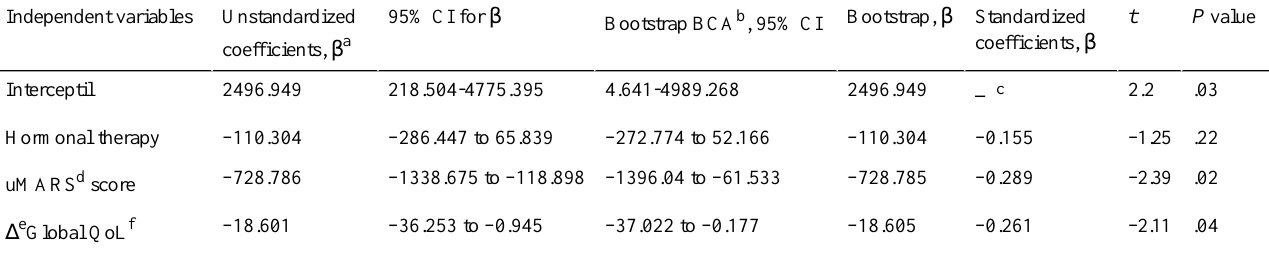
Table 3. Summary of stepwise regression analyses to determine predictors of change in C-reactive protein concentration ( r 2 =19%).